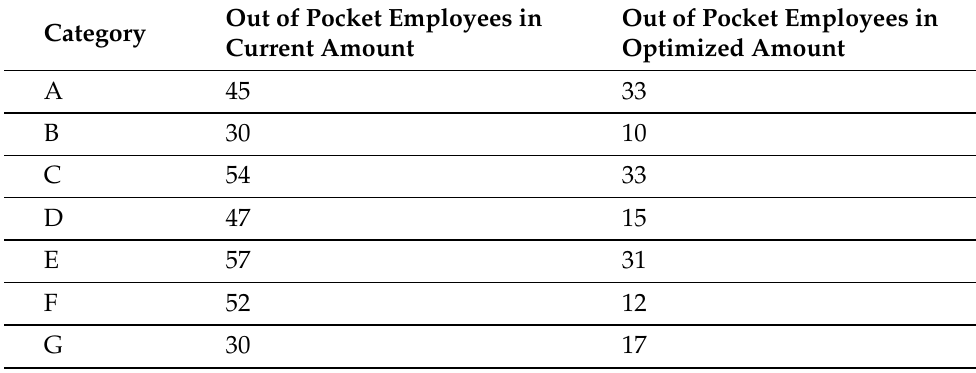
Table 16. Out of Pocket Employees in Current Medical Benefit and in Optimized